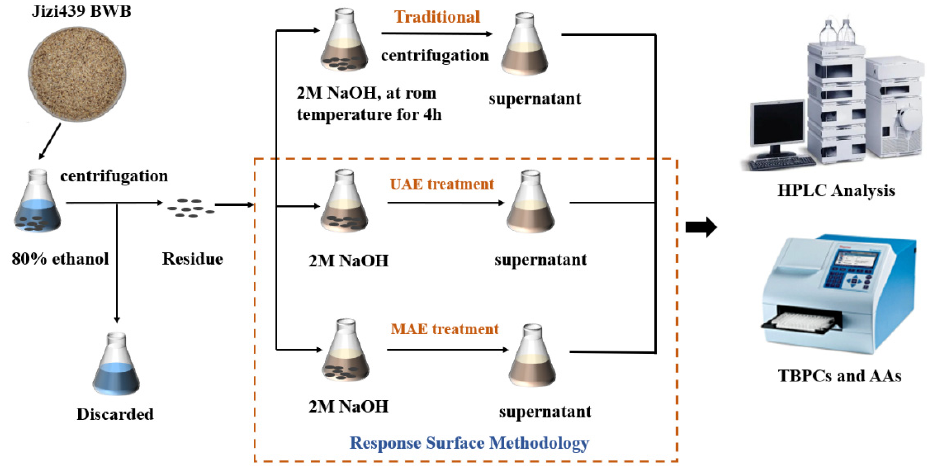
Figure 1. Methodological schematic for the extraction of bound phenolics by the traditional extraction method, UAE, and MAE; UAE, ultrasonic-assisted extraction; MAE, microwave-assisted extraction; TBPCs, total bound phenolic contents; AAs, antioxidant activities.